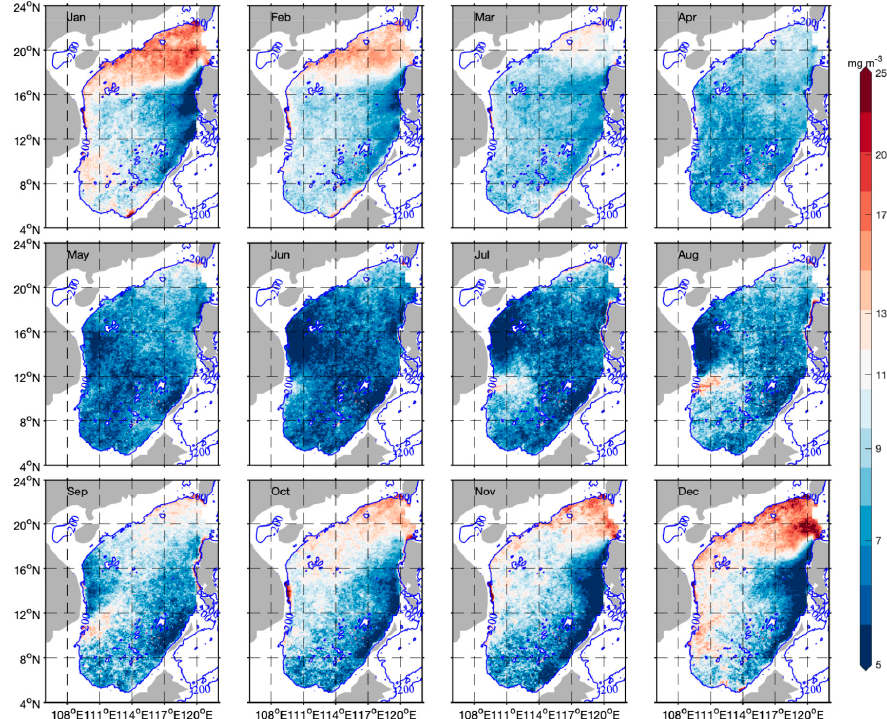
Figure 6. Monthly mean climatological distribution of the phytoplankton carbon in the South China Sea (September 1997 to December 2019). The blue line shows the 200-m isobath.